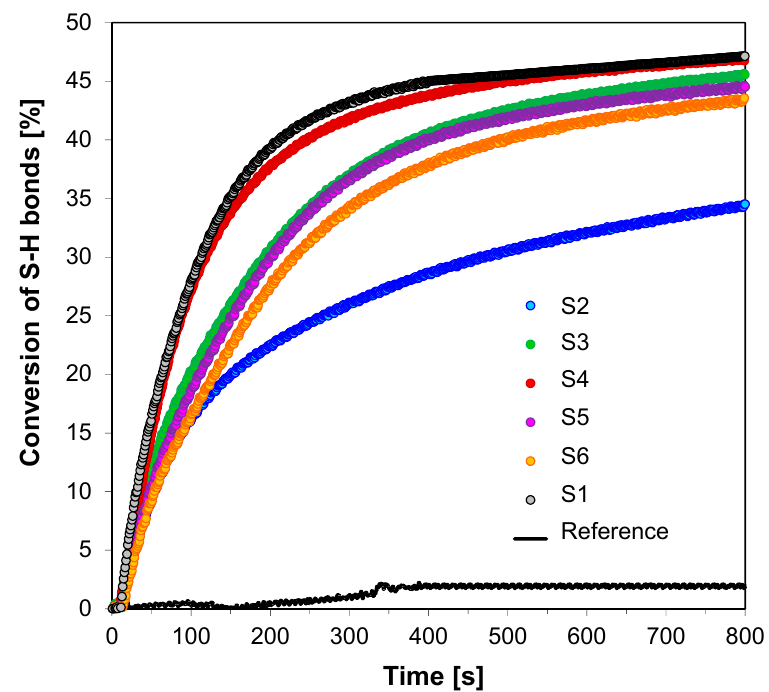
Figure 13. Conversion of S-H bonds of MERCAPTO recorded during thiol-ene photopolymerization of TMPTMA and MERCAPTO composition with binary initiating system—HIP and fluorescent probes—under UV-LED 365 nm (95mW/cm 2 ) irradiation.